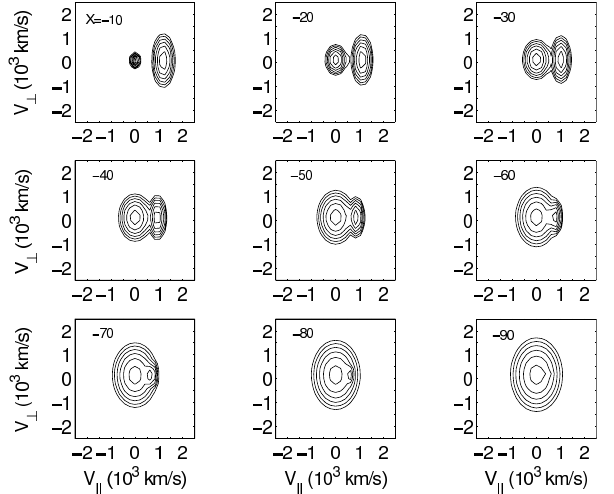
Fig. 8. Two-dimensional cuts in the V k − V ⊥ plane of the model boundary condition (BC) distribution functions at different downtail positions for positive Z . The V k direction is earthwards. In the near- Earth region the distributions are representative of the outer edge of the PSBL. In the midtail region the distributions are representative of an intermediate region including lobe-mantle plasma. The distant tail is representative of an almost pure mantle BC. The contours of constant phase space density are plotted every two decades from − 23 to − 10s 3 /m 6 .